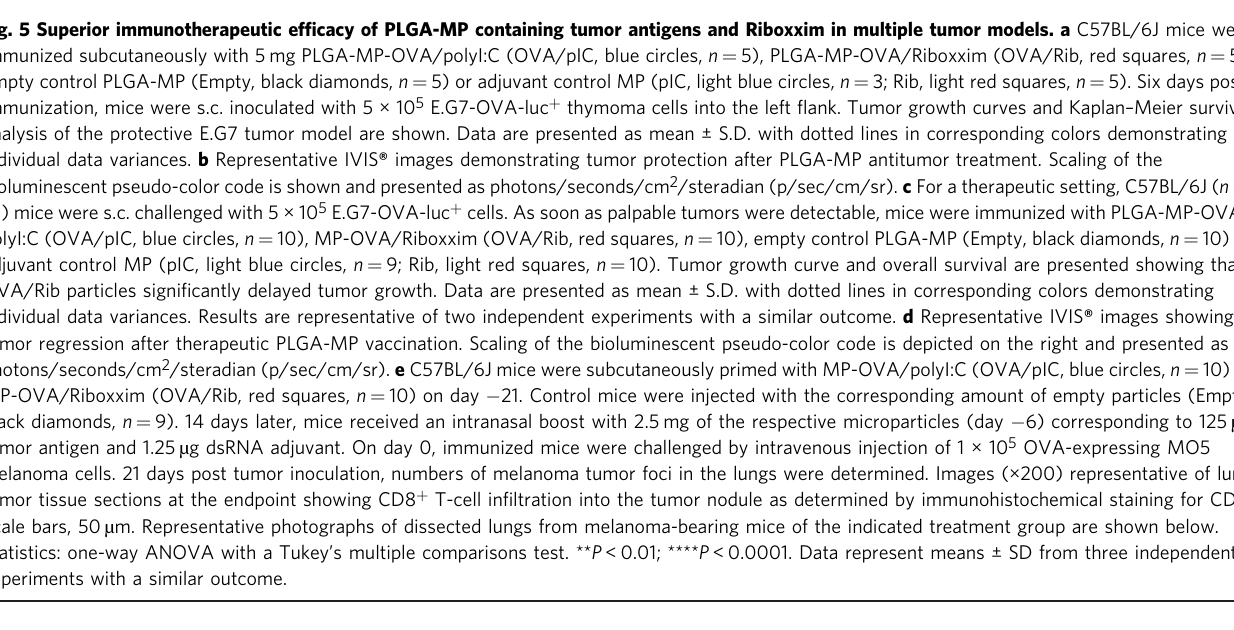
Fig. 5 Superior immunotherapeutic ef fi cacy of PLGA-MP containing tumor antigens and Riboxxim in multiple tumor models. a C57BL/6J mice were immunized subcutaneously with 5 mg PLGA-MP-OVA/polyI:C (OVA/pIC, blue circles, n = 5), PLGA-MP-OVA/Riboxxim (OVA/Rib, red squares, n = 5), empty control PLGA-MP (Empty, black diamonds, n = 5) or adjuvant control MP (pIC, light blue circles, n = 3; Rib, light red squares, n = 5). Six days post- immunization, mice were s.c. inoculated with 5 × 10 5 E.G7-OVA-luc + thymoma cells into the left fl ank. Tumor growth curves and Kaplan – Meier survival analysis of the protective E.G7 tumor model are shown. Data are presented as mean ± S.D. with dotted lines in corresponding colors demonstrating individual data variances. b Representative IVIS ® images demonstrating tumor protection after PLGA-MP antitumor treatment. Scaling of the bioluminescent pseudo-color code is shown and presented as photons/seconds/cm 2 /steradian (p/sec/cm/sr). c For a therapeutic setting, C57BL/6J ( n = 10) mice were s.c. challenged with 5 × 10 5 E.G7-OVA-luc + cells. As soon as palpable tumors were detectable, mice were immunized with PLGA-MP-OVA/ polyI:C (OVA/pIC, blue circles, n = 10), MP-OVA/Riboxxim (OVA/Rib, red squares, n = 10), empty control PLGA-MP (Empty, black diamonds, n = 10) or adjuvant control MP (pIC, light blue circles, n = 9; Rib, light red squares, n = 10). Tumor growth curve and overall survival are presented showing that OVA/Rib particles signi fi cantly delayed tumor growth. Data are presented as mean ± S.D. with dotted lines in corresponding colors demonstrating individual data variances. Results are representative of two independent experiments with a similar outcome. d Representative IVIS ® images showing tumor regression after therapeutic PLGA-MP vaccination. Scaling of the bioluminescent pseudo-color code is depicted on the right and presented as photons/seconds/cm 2 /steradian (p/sec/cm/sr). e C57BL/6J mice were subcutaneously primed with MP-OVA/polyI:C (OVA/pIC, blue circles, n = 10) or MP-OVA/Riboxxim (OVA/Rib, red squares, n = 10) on day − 21. Control mice were injected with the corresponding amount of empty particles (Empty, black diamonds, n = 9). 14 days later, mice received an intranasal boost with 2.5 mg of the respective microparticles (day − 6) corresponding to 125 µ g tumor antigen and 1.25 µ g dsRNA adjuvant. On day 0, immunized mice were challenged by intravenous injection of 1 × 10 5 OVA-expressing MO5 melanoma cells. 21 days post tumor inoculation, numbers of melanoma tumor foci in the lungs were determined. Images (×200) representative of lung tumor tissue sections at the endpoint showing CD8 + T-cell in fi ltration into the tumor nodule as determined by immunohistochemical staining for CD8. Scale bars, 50 µ m. Representative photographs of dissected lungs from melanoma-bearing mice of the indicated treatment group are shown below. Statistics: one-way ANOVA with a Tukey ’ s multiple comparisons test. ** P < 0.01; **** P < 0.0001. Data represent means ± SD from three independent experiments with a similar